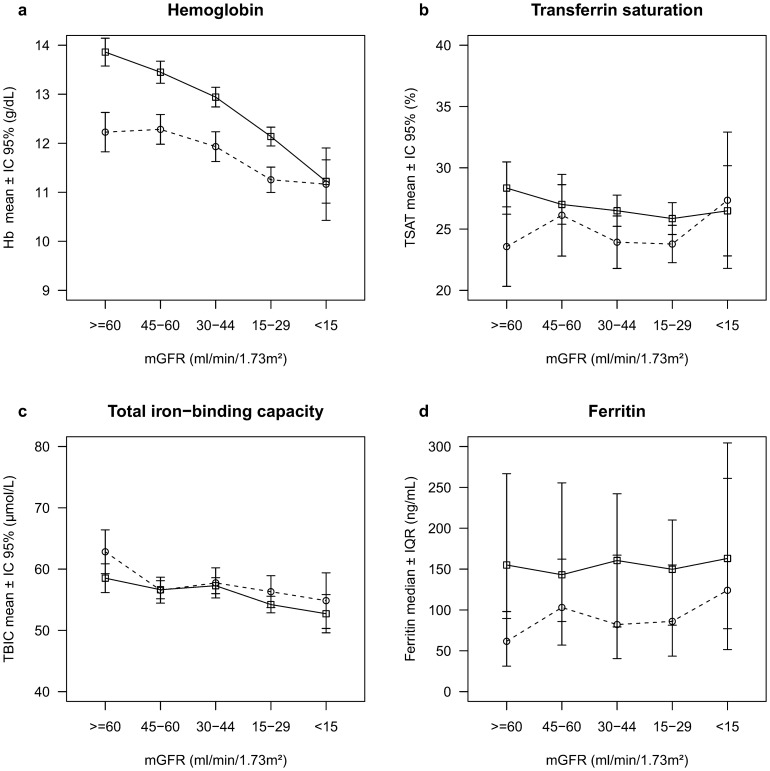
Hemoglobin, transferrin saturation (TSAT), ferritin and transferrin iron binding capacity (TIBC) according to mGFR level, by gender.Men are in solid line and women in dotted line.